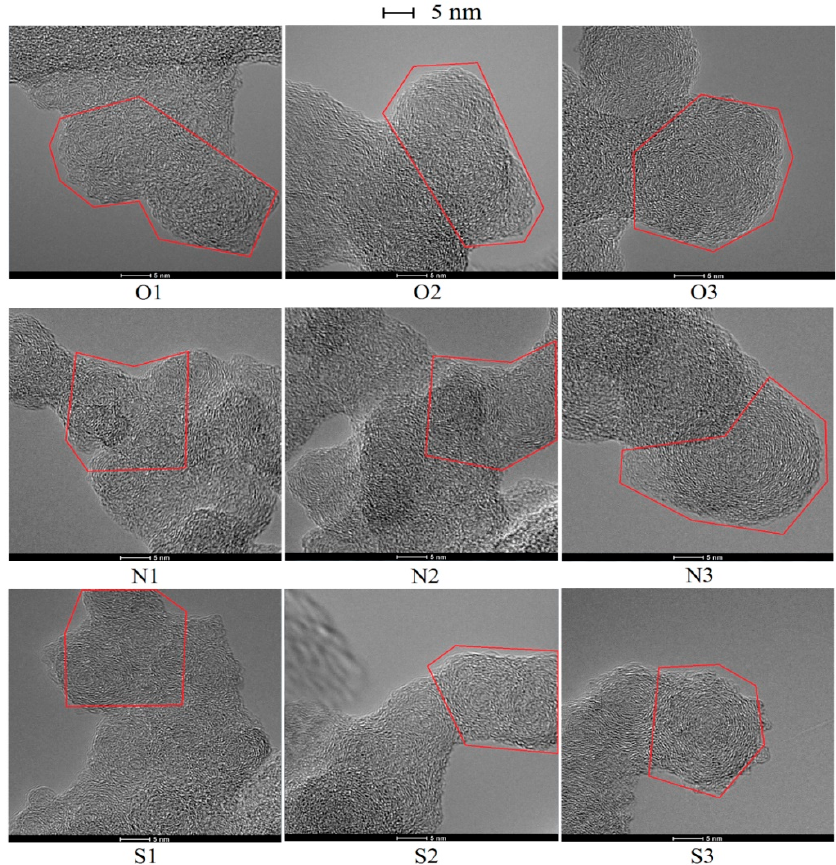
Figure 5. HRTEM images of soot particles sampled from cases listed in Table 1. (O1–O3 without effects of magnetic fields, N1–N3 with N pole of magnet facing the flame, S1–S3 with S pole of magnet facing the flame. O1, N1, S1 from pure n -heptane IDF, O2, N2, S2 from n -heptane IDF with 25% DMF-doped, O3, N3, S3 from n -heptane IDF with 50% DMF-doped).